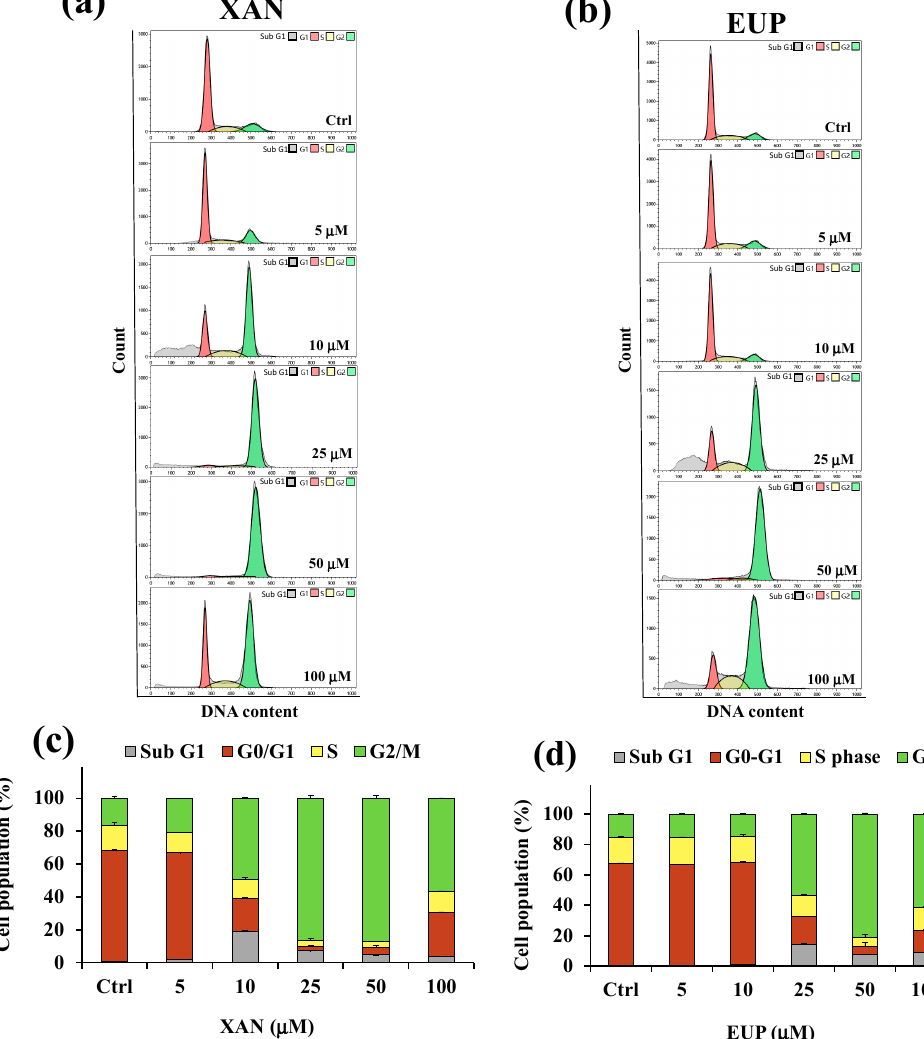
Figure 5. Flow cytometric analysis of the cell cycle distribution determined in control HeLa cells (Ctrl) and cells treated for 24 h with xanthomicrol (XAN) ( a ) and eupatilin (EUP) ( b ) at the concentration range of 5–100 μ M. Percentage values of the HeLa cells in cell cycle patterns (sub G1, G0/G1, S, and G2/M phases) determined for XAN ( c ) and EUP ( d ). Three independent experiments are performed, and data are presented as mean and SD ( n = 3).